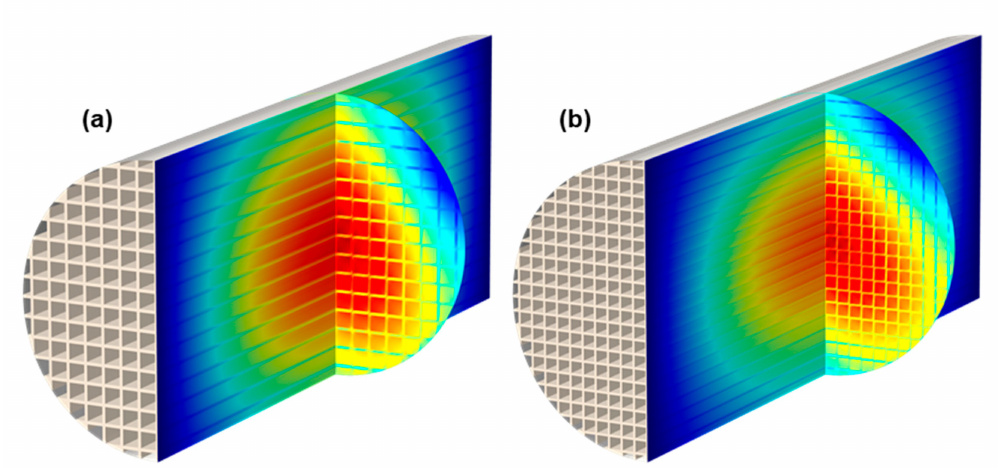
Figure 4. Simulated electric field (red: high field strength; blue: low field strength) of the TE 111 resonant mode in a monolith filter structure ( ν bulk = 30%; σ bulk = 10 mS/m) with different cell densities: ( a ) 58 cpsi; ( b ) 114 cpsi. Table 1. Parameter variation in the simulation models. Besides the bulk volume fraction of the sample ν bulk and also its conductivity σ bulk , (a) in case of the resonator model, the layer number and (b) for the filter structure, the cell density was varied (cpsi stands for cells per square inch). ν bulk